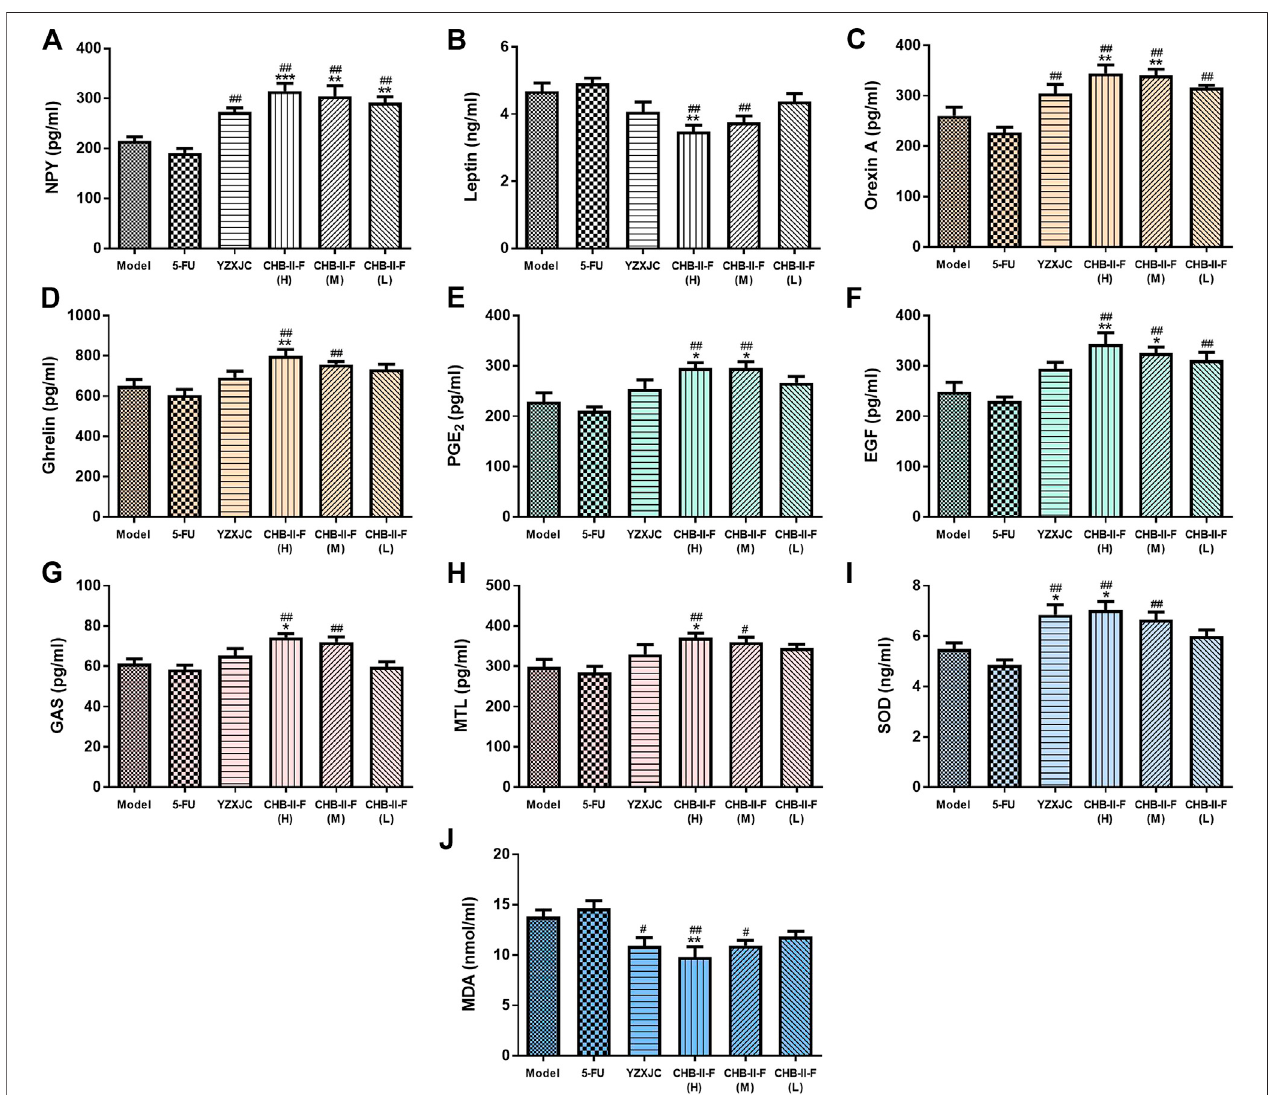
FIGURE 4 | Effects of CHB-II-F on the content of NPY, OX1R, Ghrelin, Leptin, GAS, MTL, PGE 2 , and EGF in serum, SOD, and MDA in the jejunum of the